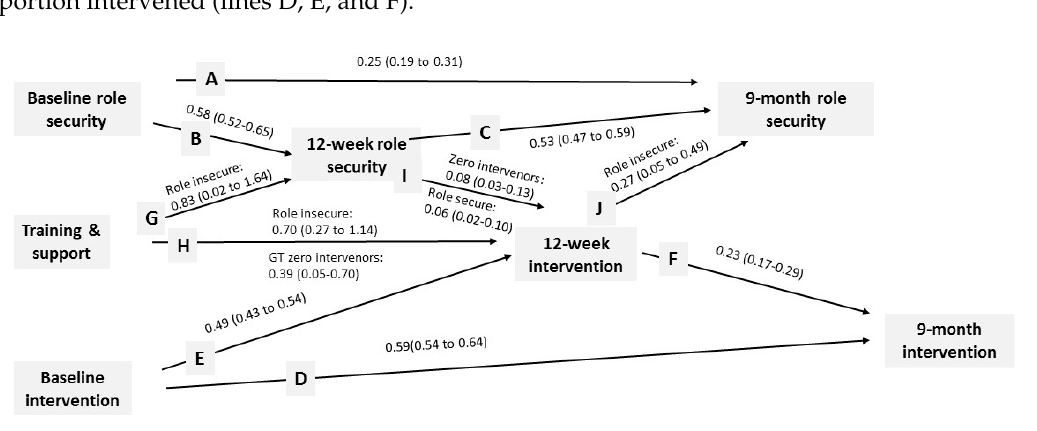
Figure 3. Unstandardized estimates (95% confidence intervals) for interrelationships between role security and the proportion of patients intervened (estimates for impact of training and support have been doubled—see statistical